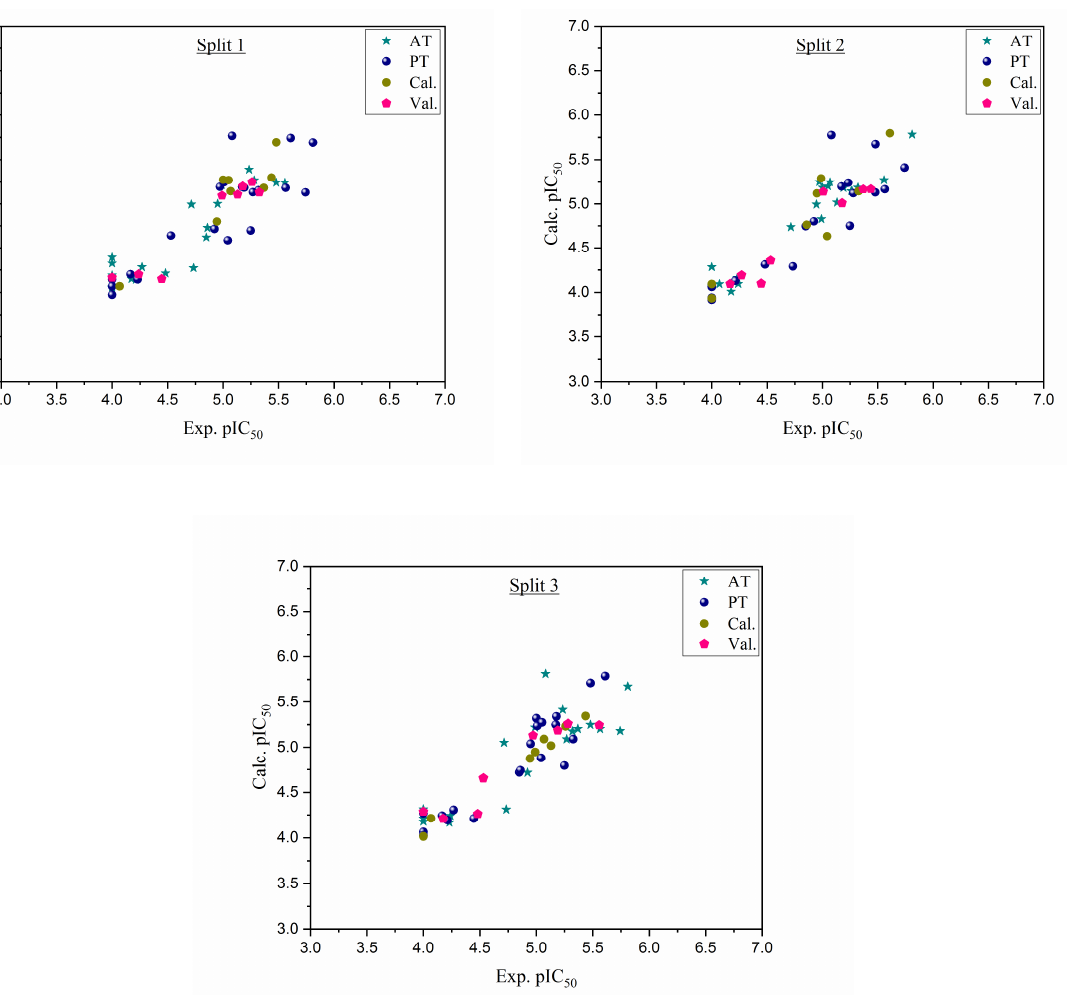
Figure 1. Graphical representation of experimental pIC 50 versus calculated pIC 50 for three splits.